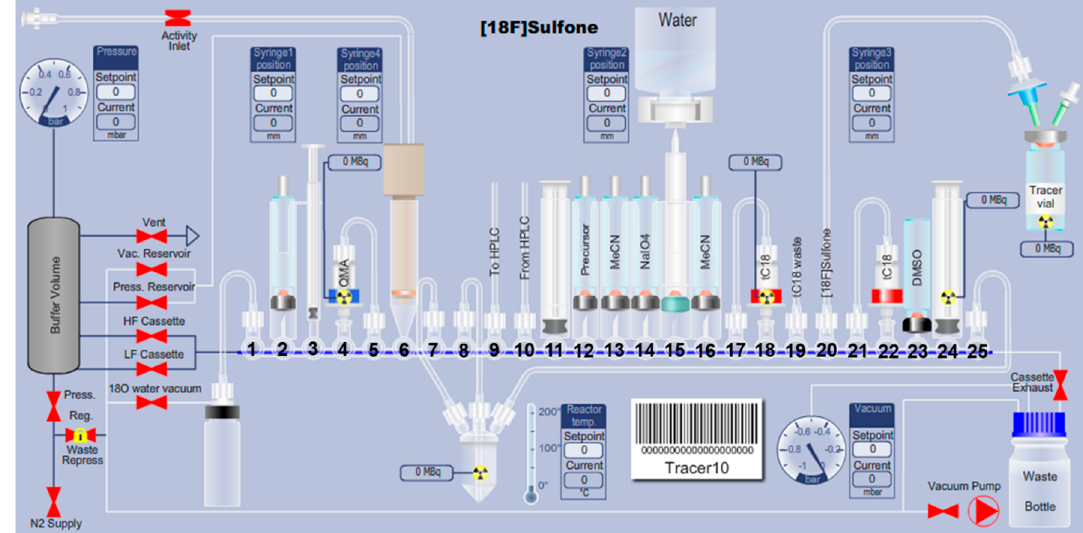
15 min (Figure 6), respectively, and formulated on the same FASTlab TM cassette by using a preconditioned Sep-Pak ® C18 Plus Short cartridge. The trapped [ 18 F]5a , [ 18 F]5c , and [ 18 F]5f were then Figure 3. Layout of the FASTlab TM cassette for the radiosyntheses of the labeled compounds [ 18 F]5a , [ 18 F]5c , and [ 18 F]5f . eluted with anhydrous DMSO using reverse flow and recovered in a 4 mL-sealed vial.